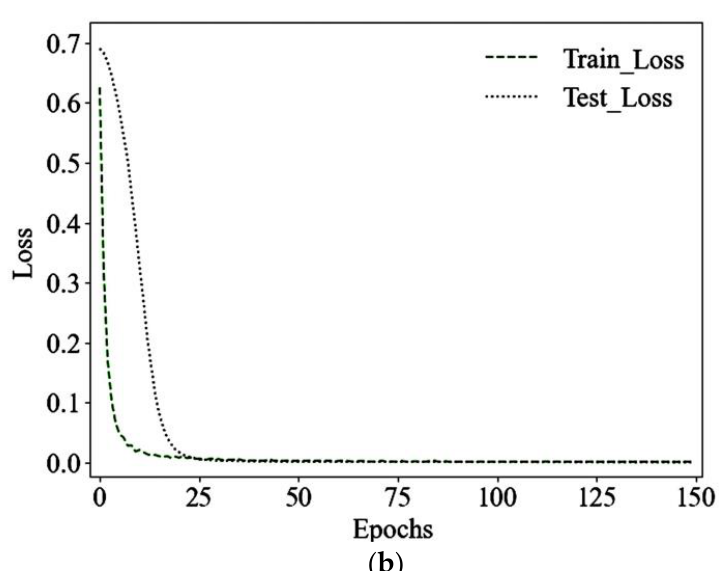
Figure 7. Accuracy and loss. ( a ) Accuracy; ( b ) loss.